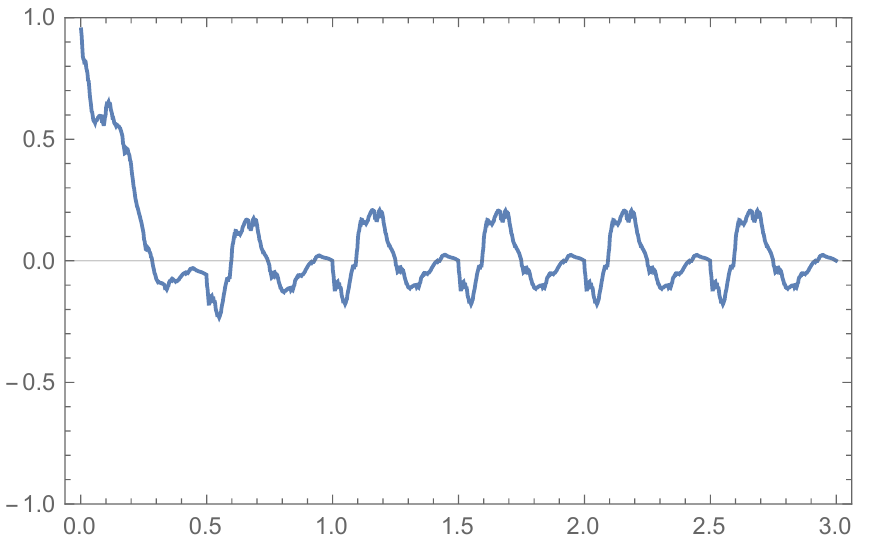
) and b ( t ) = cos ( π t 2